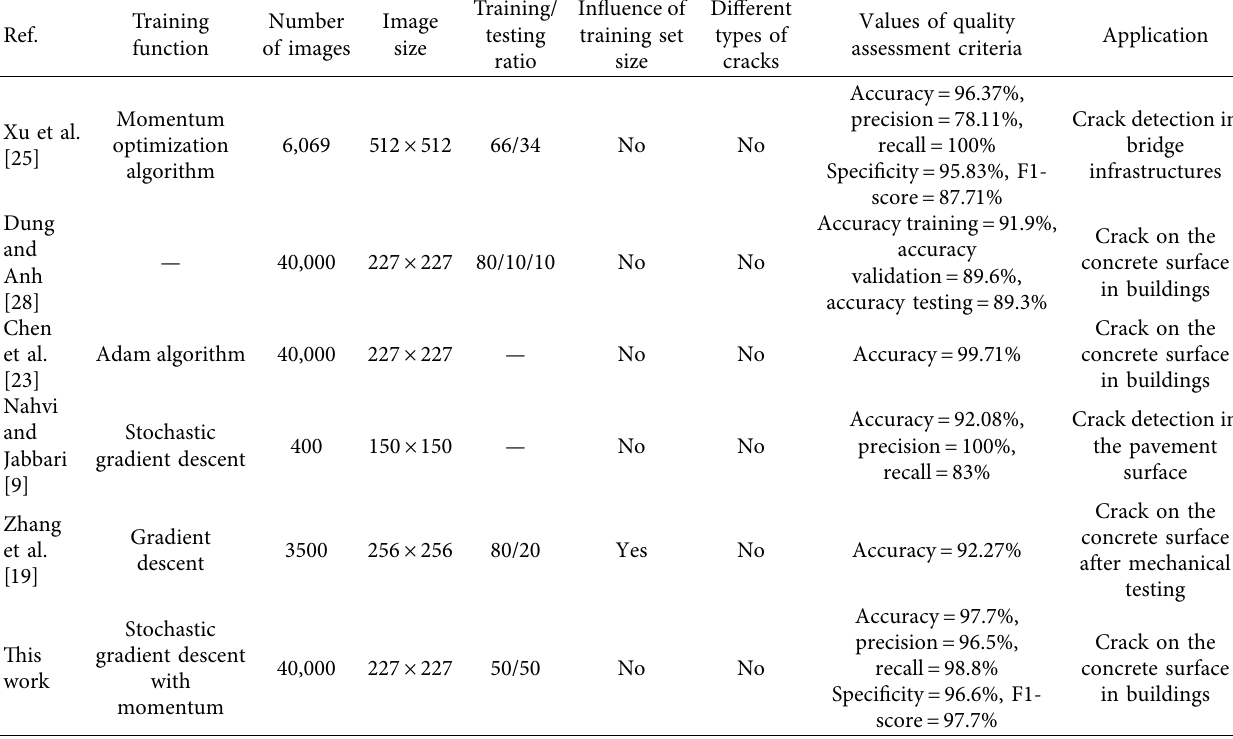
Figure 8: Several configurations where the CNN model could not detect the cracks. (a) Image with cracks in the corners. (b) Image with low resolution. (c) Image with too small cracks. Table 5: Summary of publications using image-based CNN technique for crack